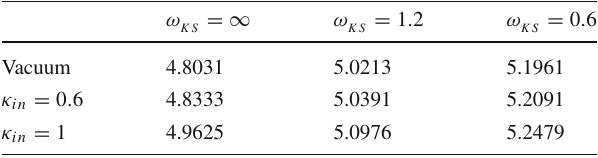
Table 1 In this table, the radius of the shadow for upper three images in Fig. 2 is written for different combinations of ω